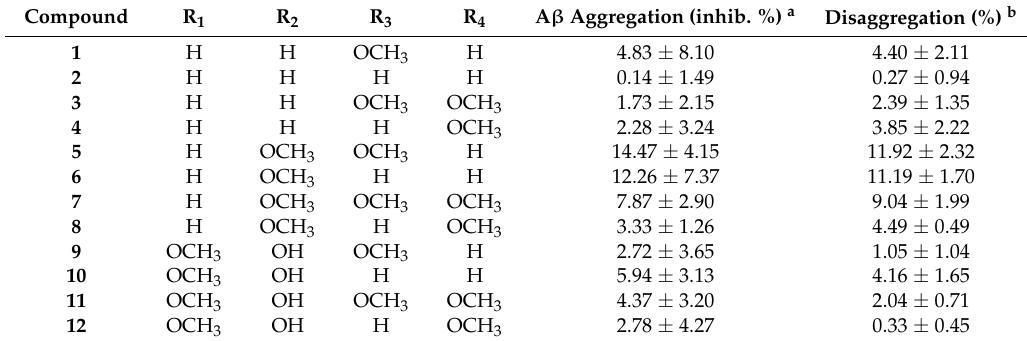
Table 2. Thioflavin T (ThT) assay results for compounds 1 – 20